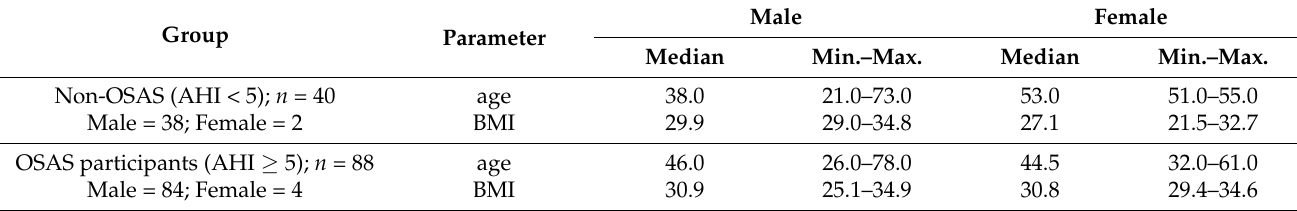
Table 1. Age and body mass index (BMI) of the male and female participants of the study. Group Parameter